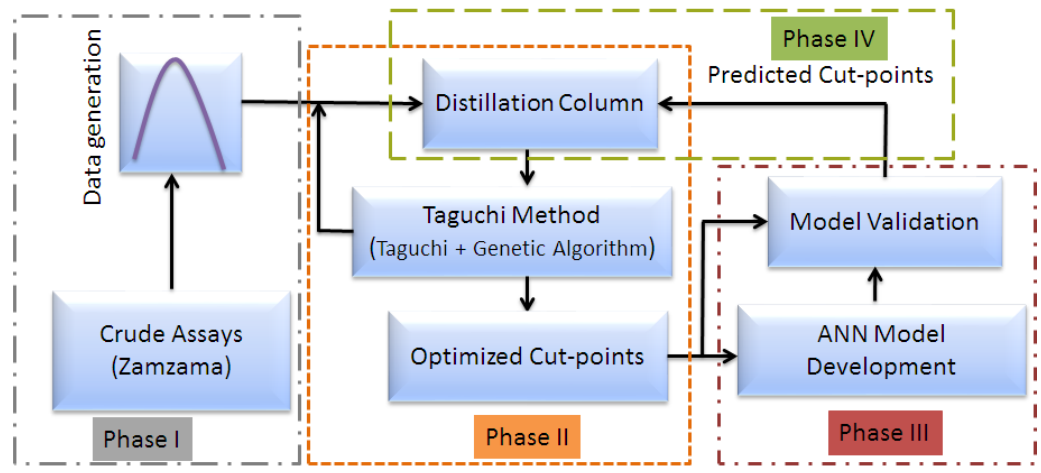
Figure 4 . Schematic diagram of integration of hybrid framework and ANN model. Figure 4. Schematic diagram of integration of hybrid framework and ANN model.